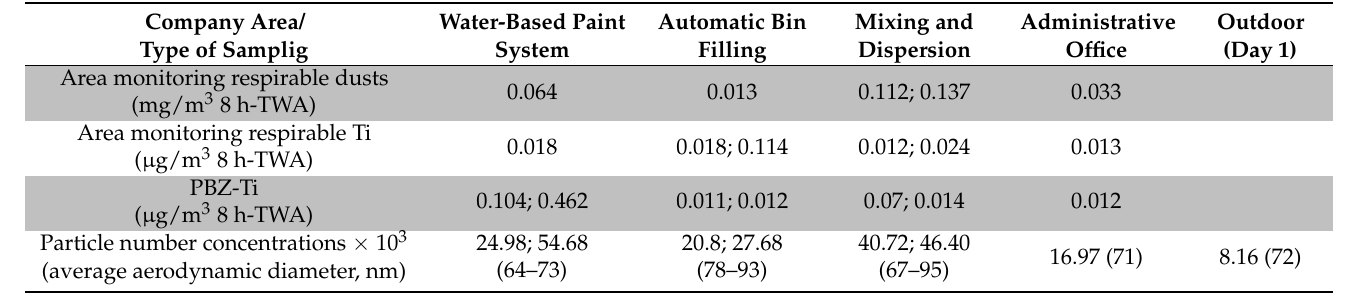
Table 1. Results of the sampling of airborne dust in the different production environments. PBZ: personal breathing one.